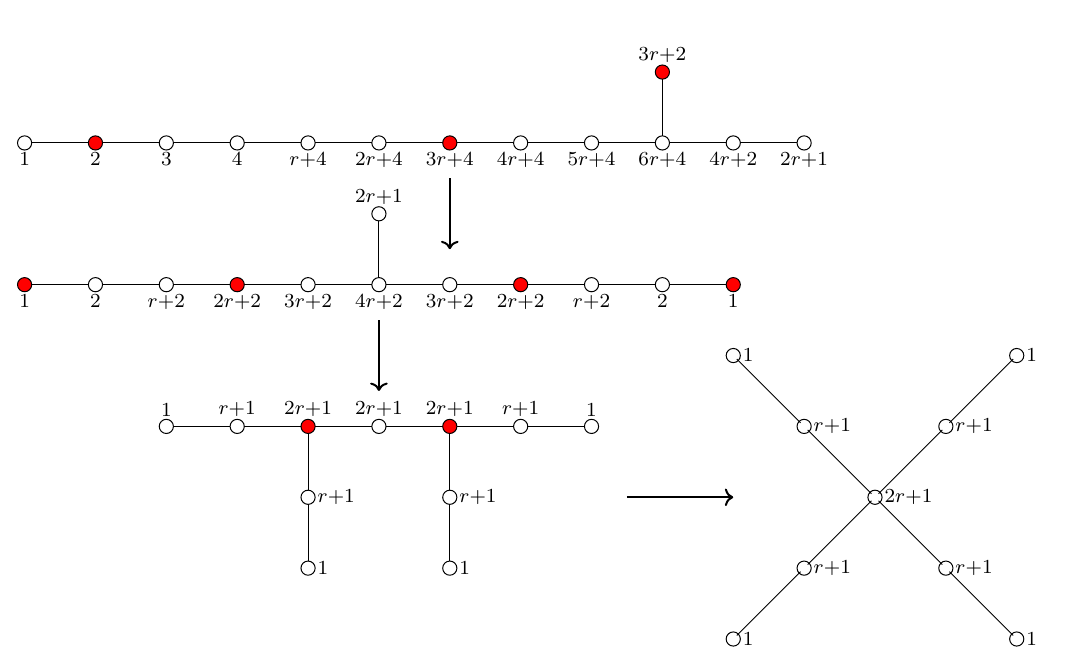
Figure 9. The FI deformations leading to a magnetic quiver which, upon Z 4 folding, leads to the magnetic quiver of the S ( r ) theories, see table 1. A 2 , 4